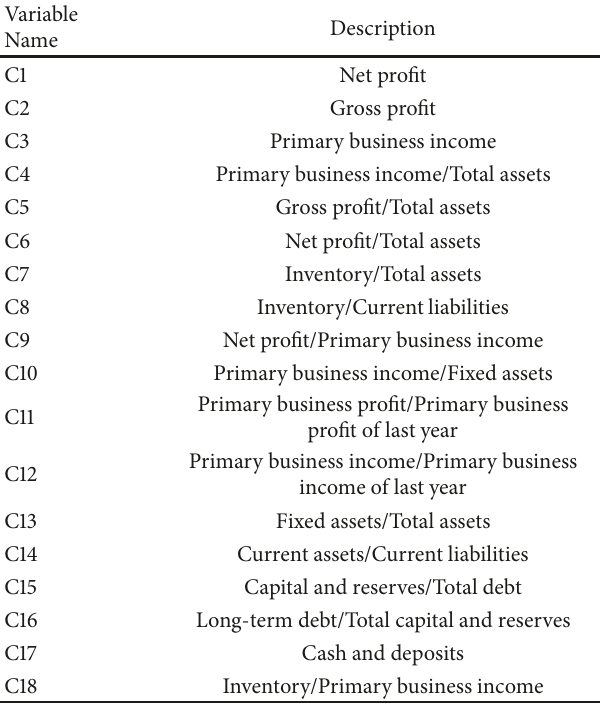
Table 1: A brief description of the variables used in this study.